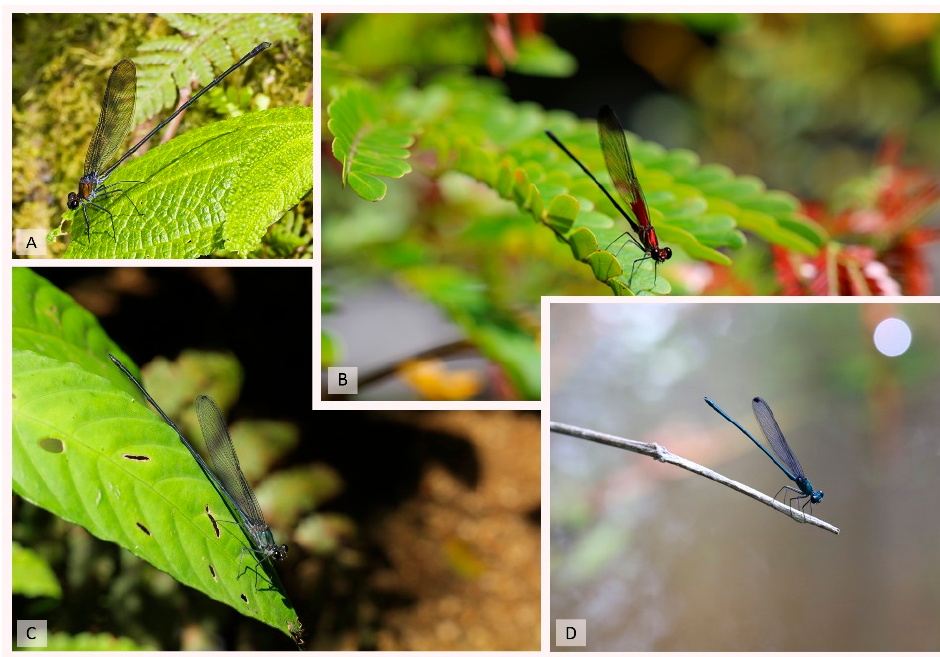
Figure 1. Habitus images showing diversity between the four genera of Hetaerininae. ( A ) Ormenophlebia imperatrix , photo by Jim Johnson; ( B ) Hetaerina amazonica , photo by R. Guillermo-Ferreira; ( C ) Mnesarete guttifera , photo by R. Guillermo-Ferreira; ( D ) Bryoplathanon globifer , photo by Tom Kompier.